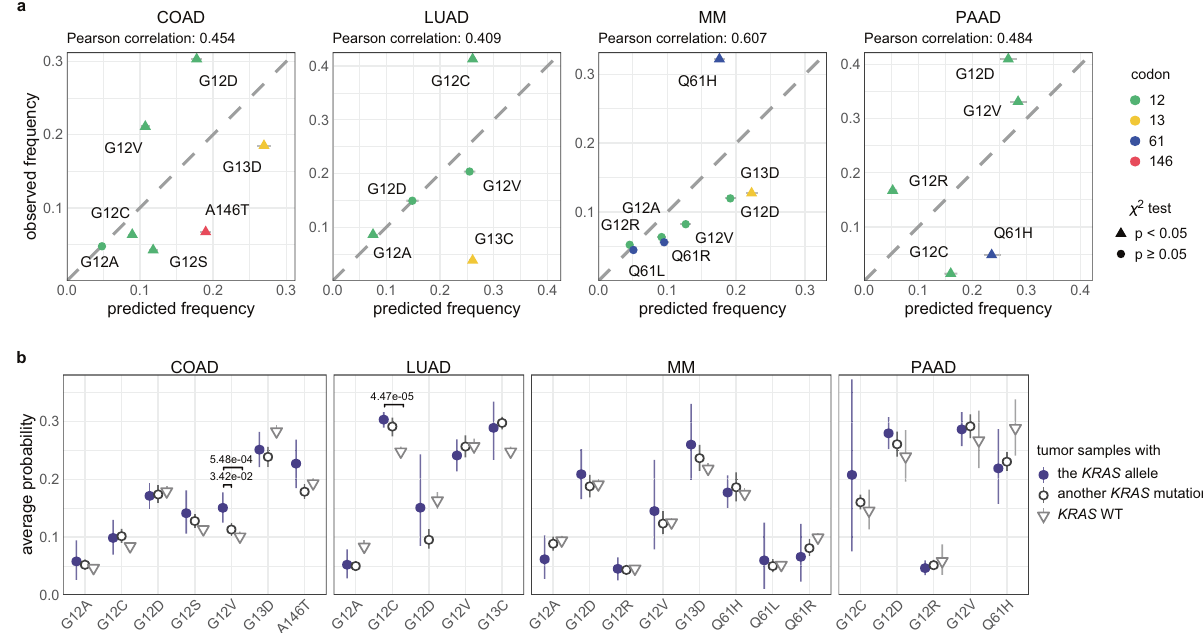
Fig. 2 The predicted frequencies of cancer-speci fi c KRAS alleles. a The predicted versus observed frequency of KRAS alleles for the common alleles of each cancer. Triangles indicate rejection of the null hypothesis that the observed and predicted frequencies are the same ( χ -squared test, p values were adjusted using the Benjamini – Hochberg FDR correction method, hereon referred to as FDR-adjusted p values; FDR-adjusted p value < 0.05); circles indicate the failure to reject the null hypothesis ( χ -squared test, FDR-adjusted p value (cid:1) 0.05). Error bars indicate bootstrapped 95% con fi dence intervals of the predicted values. b The average probability of the indicated KRAS allele in tumors samples with the KRAS allele (closed circle), tumors samples with a different KRAS mutation (open circle), and tumor samples with WT KRAS (upside-down triangle). The errors bars indicate bootstrapped 95% con fi dence intervals of the mean. For each allele, differences in the probabilities between tumor samples with the allele and those with another allele, and between tumor samples with the allele and those with WT KRAS were tested via a Wilcoxon rank-sum test (FDR-adjusted p values < 0.05 are indicated). Source data are provided in the Source data fi